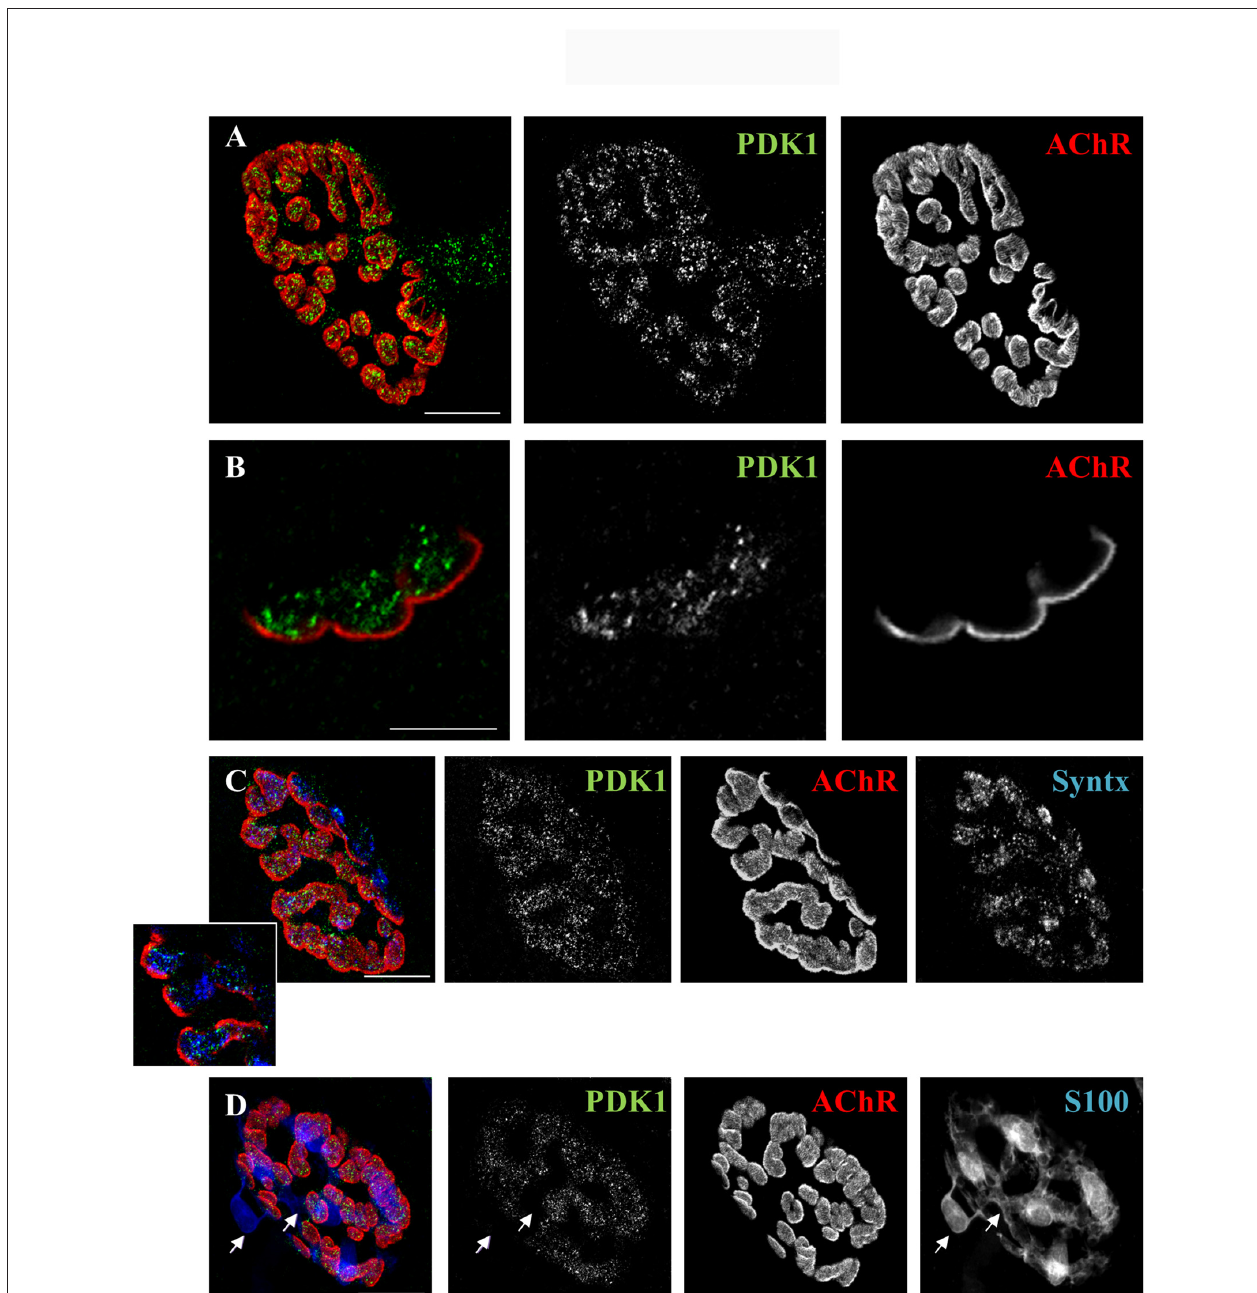
FIGURE 2 | PDK1 is localized in the nerve terminals of the neuromuscular junction (NMJ). (A,B) Double staining labeled PDK1 (in green) and AChRs (fluorescent α -BTX in red). The images show PDK1-positive green immunolabeling concentrated at the presynaptic area over the red postsynaptic gutters. (C) Triple staining labeled PDK1 (in green), AChRs (in red) and nerve terminal (with anti-syntaxin antibody in blue, Syntx). The fine granulated label for PDK1 was well colocalized with syntaxin in the presynaptic nerve terminal position (over the AChRs-positive postsynaptic red gutters). (D) Triple staining labeled PDK1 (in green), AChRs (in red) and Schwann cell (with anti-S100 antibody in blue) showed that PDK1 was not colocalized with Schwann cell (see arrows). Thus, indicating that PDK1 is exclusively located at the presynaptic component of NMJ ( n = 5; 25–30 endplates per muscle). The scale bars indicate 10 µ m. Abbreviations: PDK1, phosphoinositide- dependent kinase 1; AChRs, Acetylcholine receptors; Syntx, syntaxin; S100, S100 protein; α -BTX, α